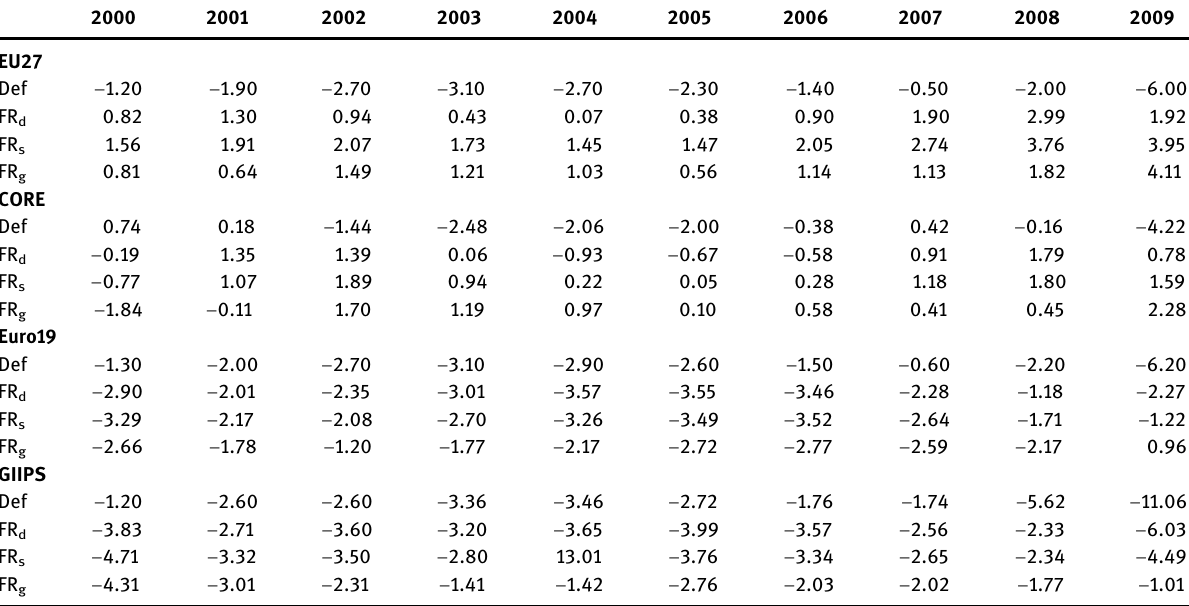
Table 1A: Government de fi cit ( − ) /surplus (+) , 2000 – 2009, ψ =